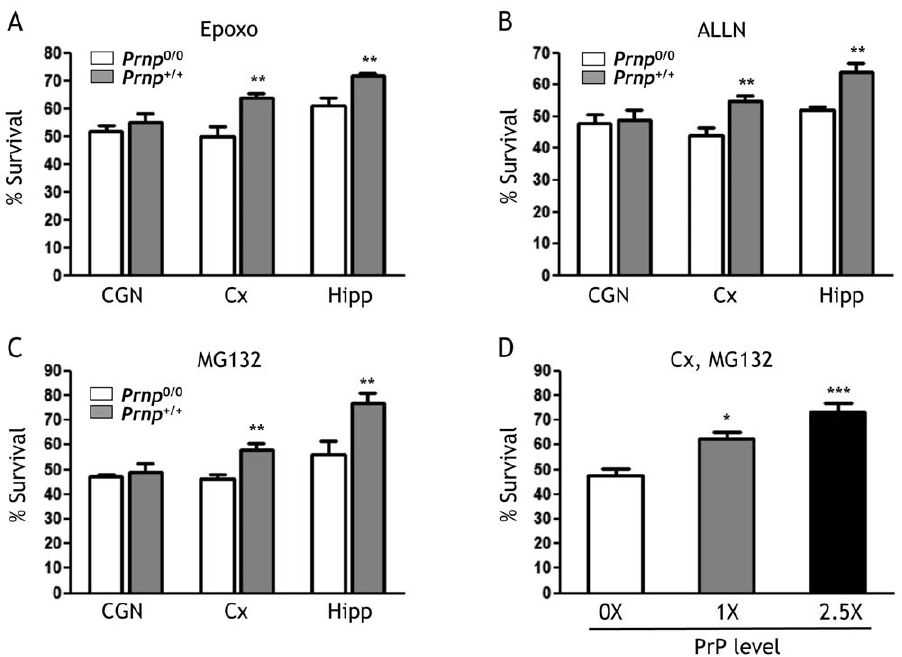
Figure 4. Neurons synthesizing SP-PrP are more resistant to proteasome inhibitors. Cerebellar granule neurons (CGN), cortical (Cx) and hippocampal (Hipp) neurons prepared from C57BL/6J ( Prnp + / + ) and PrP knockout ( Prnp 0/0 ) mice were exposed to 1 m M epoxomicin (A), 100 m M ALLN (B) or 5 m M MG132 (C). Cell survival was quantified after 24 h by MTT assay and expressed as a percentage of the values for cells treated with the vehicle. Data are the mean 6 SEM of 12–24 replicates from 2–4 independent experiments; ** p , 0.01 by Tukey-Kramer test. (D) Cortical neurons were prepared from Prnp 0/0 (PrP level: 0X), Prnp + / + (PrP level: 1X), and Tg(WT-E1) + / 2 / Prnp + /0 (PrP level: , 2.5X) littermates obtained by crossing Tg(WT-E1) + / 2 / Prnp + /0 and Prnp + /0 mice. Cell viability was analyzed after 24-h treatment with 5 m M MG132 and expressed as a percentage of the values for cells treated with the vehicle. Data are the mean 6 SEM of 8-23 replicates from 2 independent experiments; * p , 0.05, *** p , 0.001 by Dunnett’s